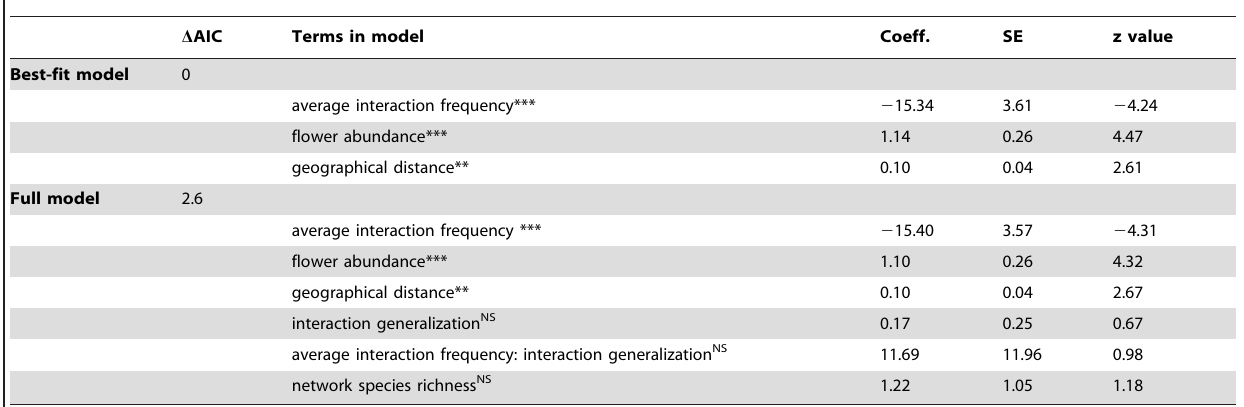
Table 1. Model terms and their